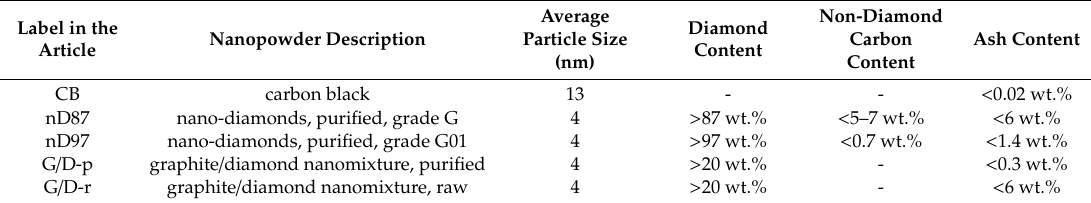
Table 1. Studied carbon nanopowders †